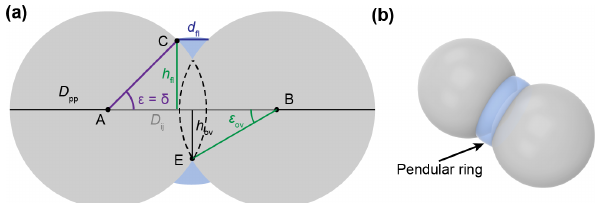
Figure B3. (a) Two-dimensional illustration of the slit-shaped pore formed between two overlapping spherical particles of the diameter D pp . The liquid water phase forms a pendular ring of water. The two principal radii of curvature of the pendular water ring are given by r c1 and r c2 , which are related to h fl and d fl , respectively (see text for details). (b) The three-dimensional shape of the pendular ring can be obtained by revolving the slit-shaped water phase (blue) about the axis described by the line between points A and B. Represented in panel (b) is a ring corresponding with a contact angle of θ sw = 60 ◦